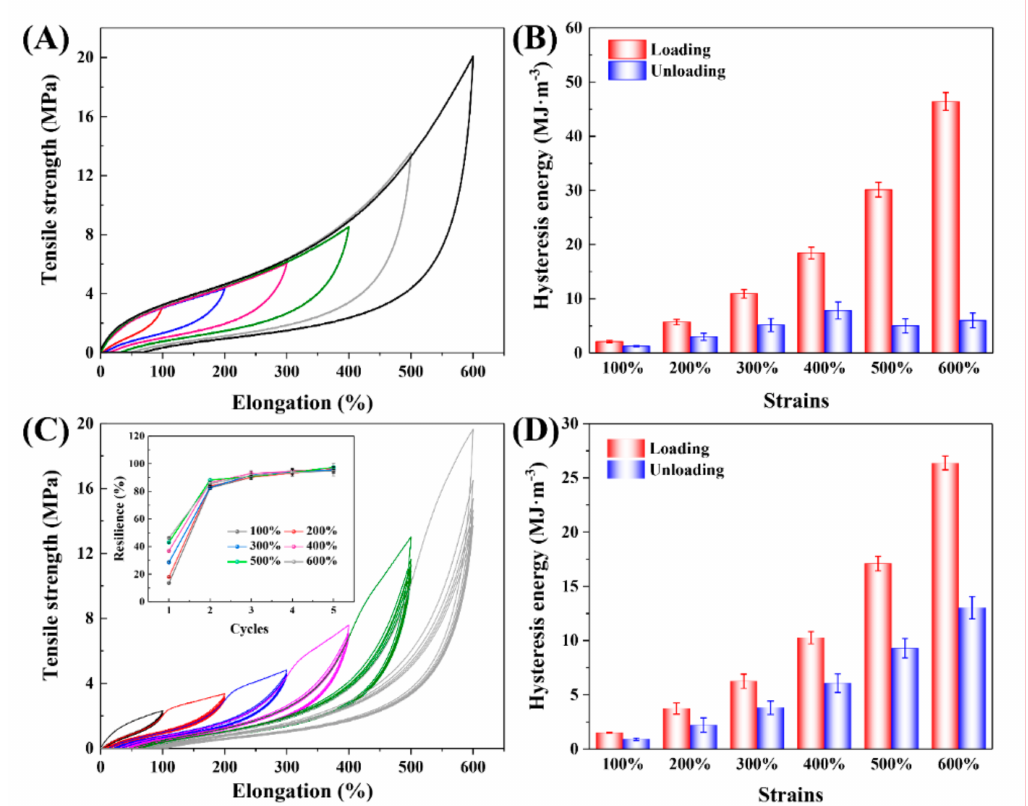
Figure 4. ( A ) Loading–unloading curves of GEL-0.5 stretched for one cycle under di ff erent strains (new GEL-0.5 for every cycle); ( B ) the calculated hysteresis energy during the cyclic tensile tests in ( A ); ( C ) loading–unloading responses of the same GEL-0.5 submitted to gradient increasing strain (increase the strain after 6 cycles under every fixed strain); and ( D ) the calculated hysteresis energy of ( C ) during the first cycle of the softening process.